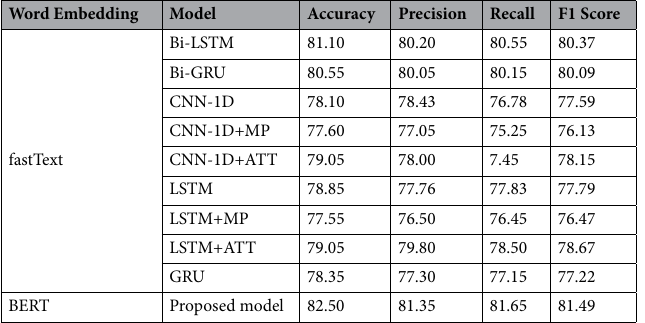
Table 10. Urdu sentiment analysis results using deep learning models for UCSA corpus.